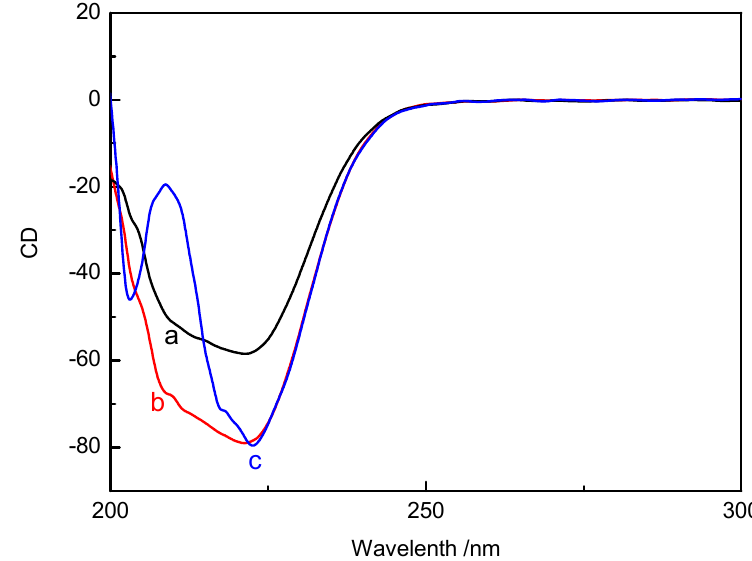
Figure 5. CD spectra of MDH in absence and presence of Al(III) and Al ( b ) MDH + Al(III) ( c ) MDH+Al